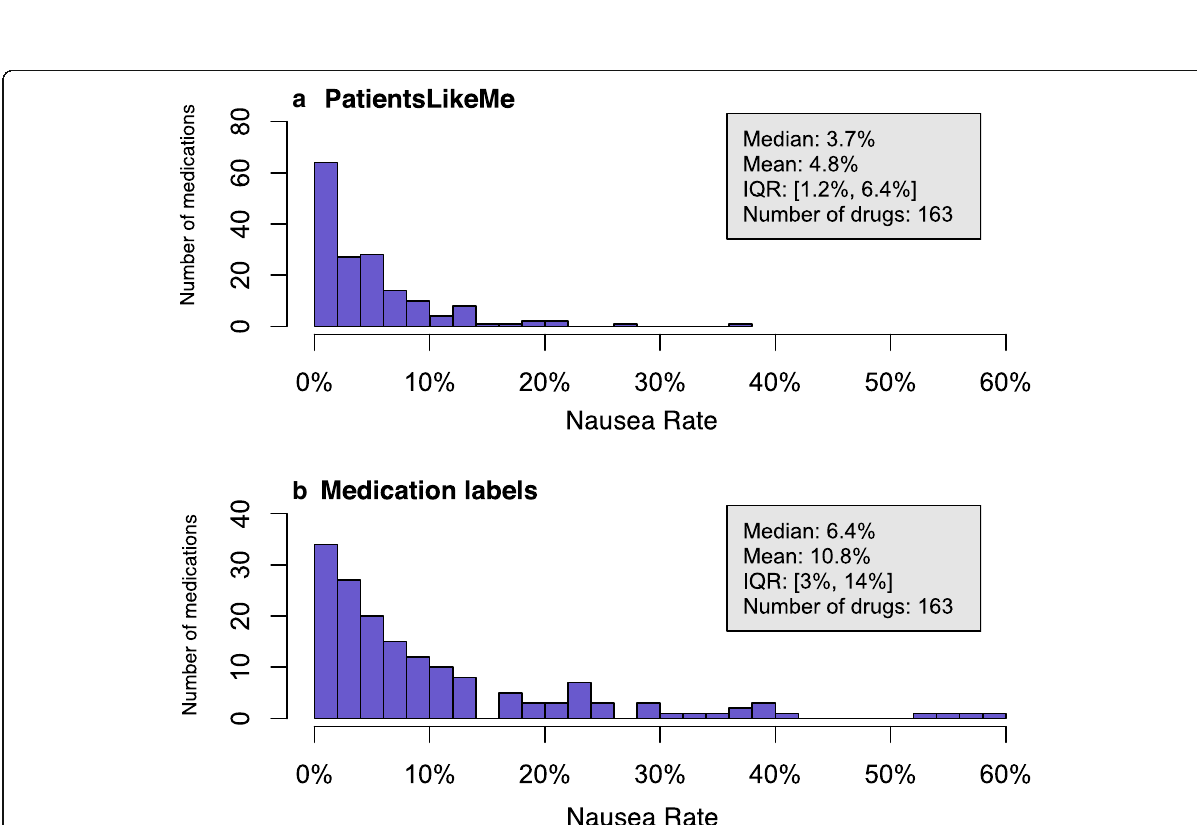
Fig. 2 Distribution of median reported nausea rates for 163 medications (aggregated by active ingredient). IQR = interquartile